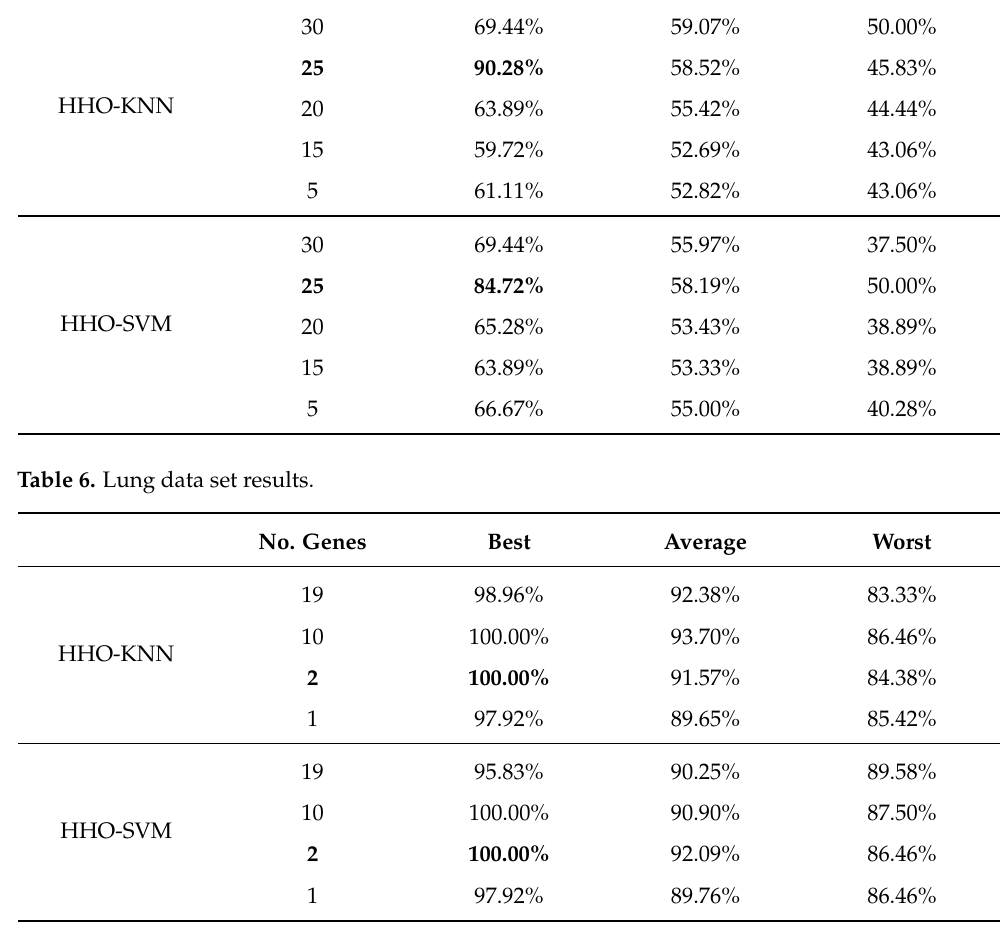
Table 7. Lymphoma data set